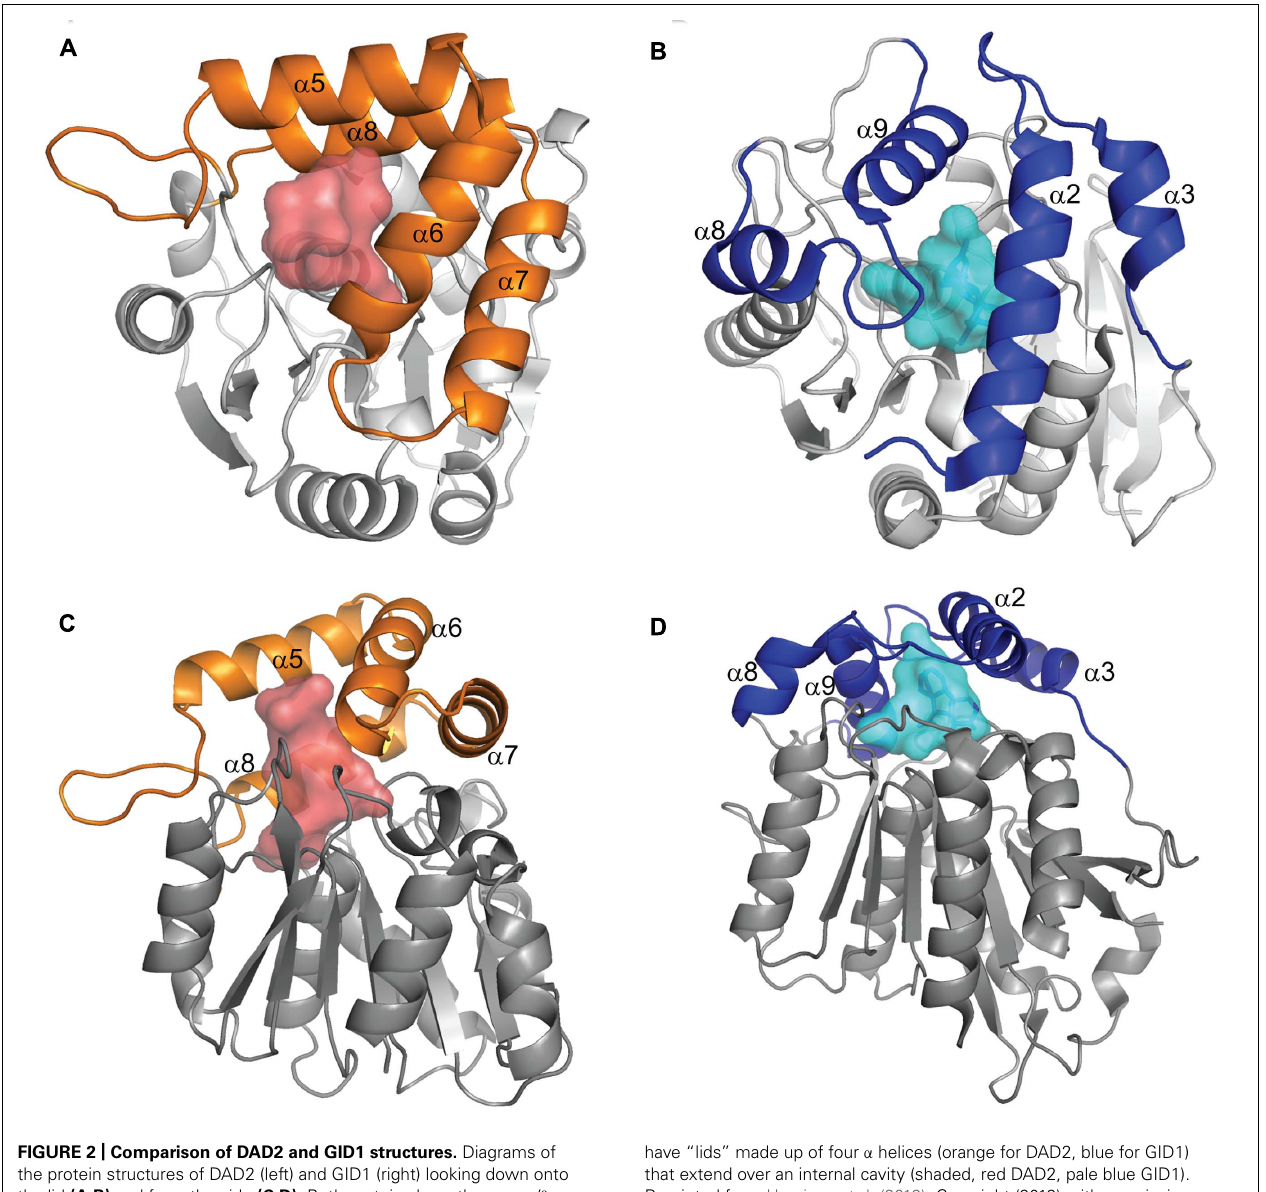
have “lids” made up of four α helices (orange for DAD2, blue for GID1) that extend over an internal cavity (shaded, red DAD2, pale blue GID1). Reprinted from Hamiaux etal. (2012), Copyright (2012) with permission from